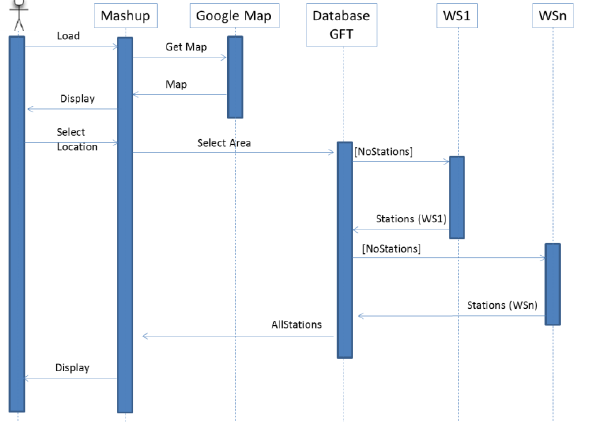
Fig. 1. UML sequence diagram of the retrieving and visualization of weather stations data.